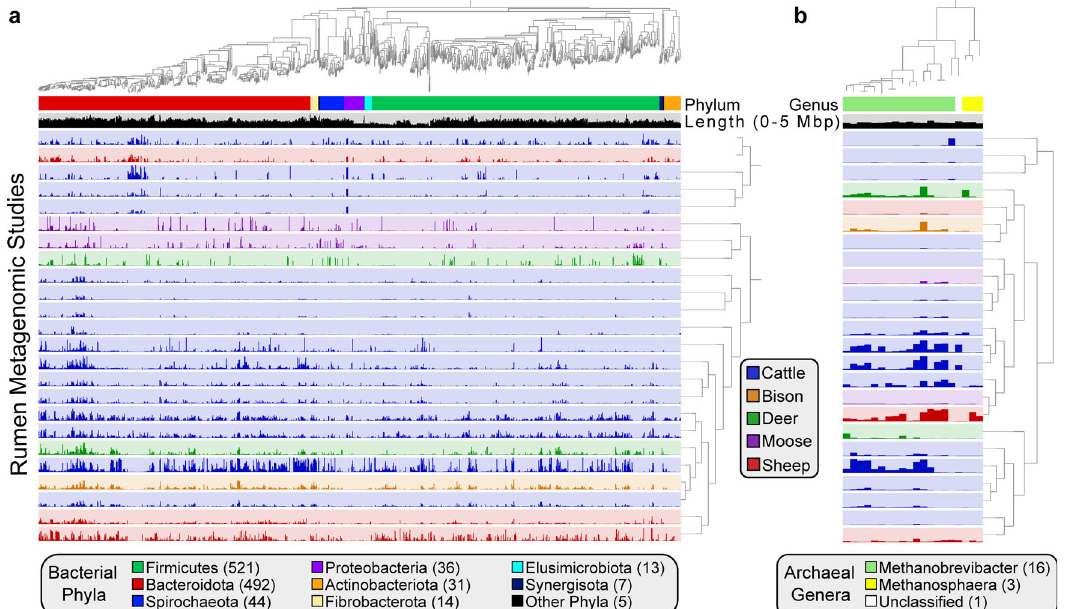
Fig. 2 Phylogenetic relationships and coverage patterns of near-complete MAGs. a Phylogenomic analysis of 1,163 near-complete ( ≥ 90% complete, ≤ 5% contamination, and N50 ≥ 15 kbp) bacterial MAGs and ( b ) 20 near-complete archaeal MAGs inferred from the concatenation of phylogenetically informative proteins. Layers below the genomic trees designate bacterial phylum or archaeal genus based on GTDB taxonomic assignments, genomic size (0 – 5 Mbp), and the mean number of bases with ≥ 1× coverage in a rumen metagenomic dataset (layer color indicates the ruminant the data was collected from). The mean number of bases with ≥ 1× coverage was used as input for hierarchical clustering of rumen metagenomic datasets based on Euclidean distance and Ward linkage. The bacterial and archaeal phylogenetic trees are provided as Supplementary Data 6 and Supplementary Data 7,